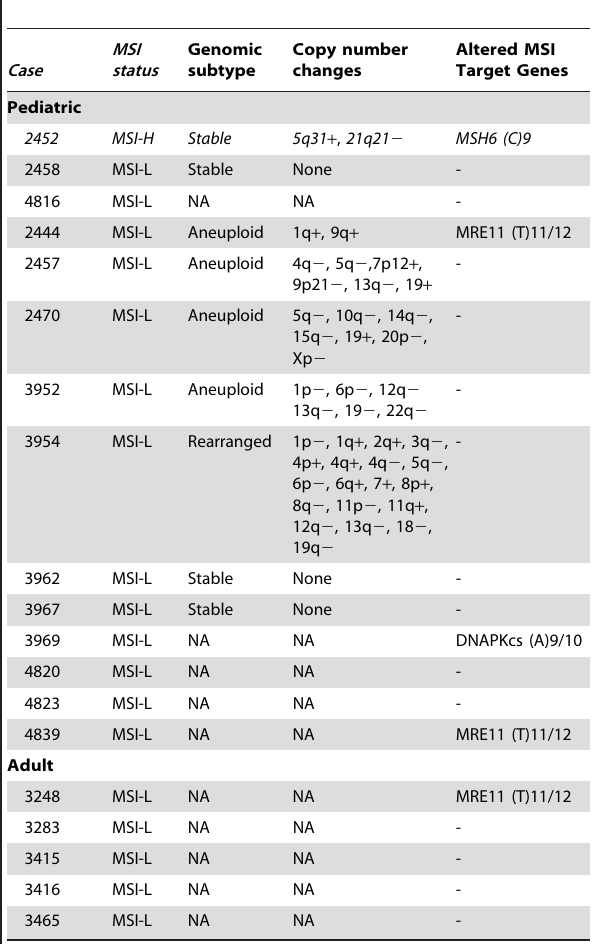
Table 2. Genomic alterations and Candidate MSI target genes frameshift mutations in MSI